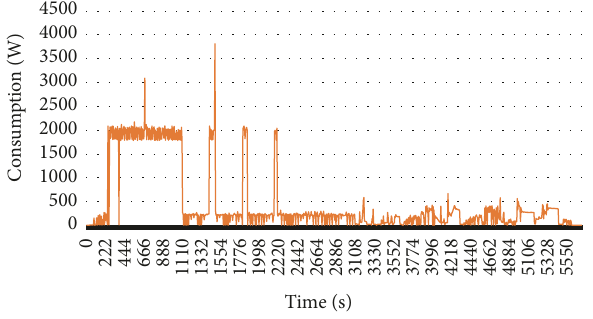
Figure 14: TV activation period.